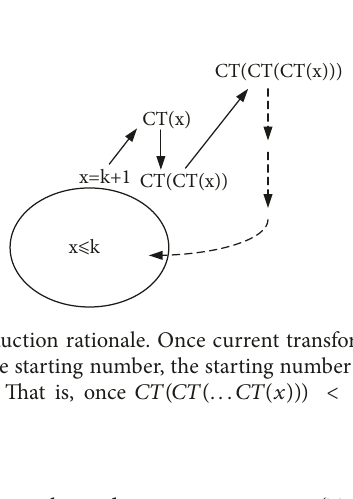
RTN ) due to the induction assumption ( ∀𝑥 ≤ 𝑘, 𝑥